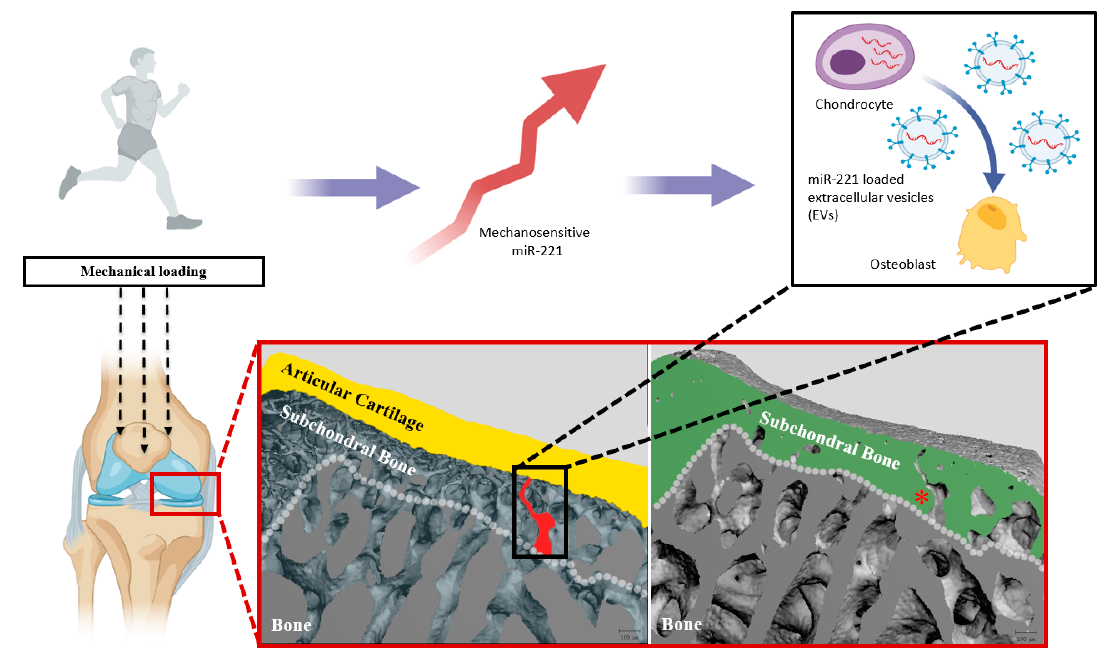
Figure 9. Theoretical scheme of how chondrocyte-secreted EVs harboring miR-221-3p may affect osteoblasts in the physiological condition of joint. The healthy knee joint can be affected by mechanical loading, which increases miR-221-3p expression in the cartilage chondrocytes. Chondrocytes secrete EVs that contain these miRNAs, which can then be taken up by osteoblasts via the microchannel network of the subchondral bone. Subchondral bone (green) and its intricate microarchitecture (red asterisk) are illustrated by the 3D-reconstructed images acquired by high-resolution micro-computed tomography. In the inverted model, the articular cartilage is demonstrated in yellow, while the continuous nature of porous structures (i.e., microchannels; one of which is marked in red color) is visible throughout the entire subchondral bone. These microchannels may be the main pathways of bone–cartilage communication.